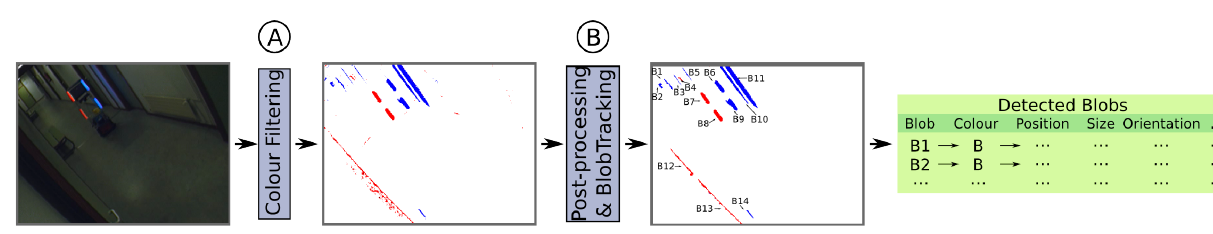
Figure 8. Stage 1: Blob detection and